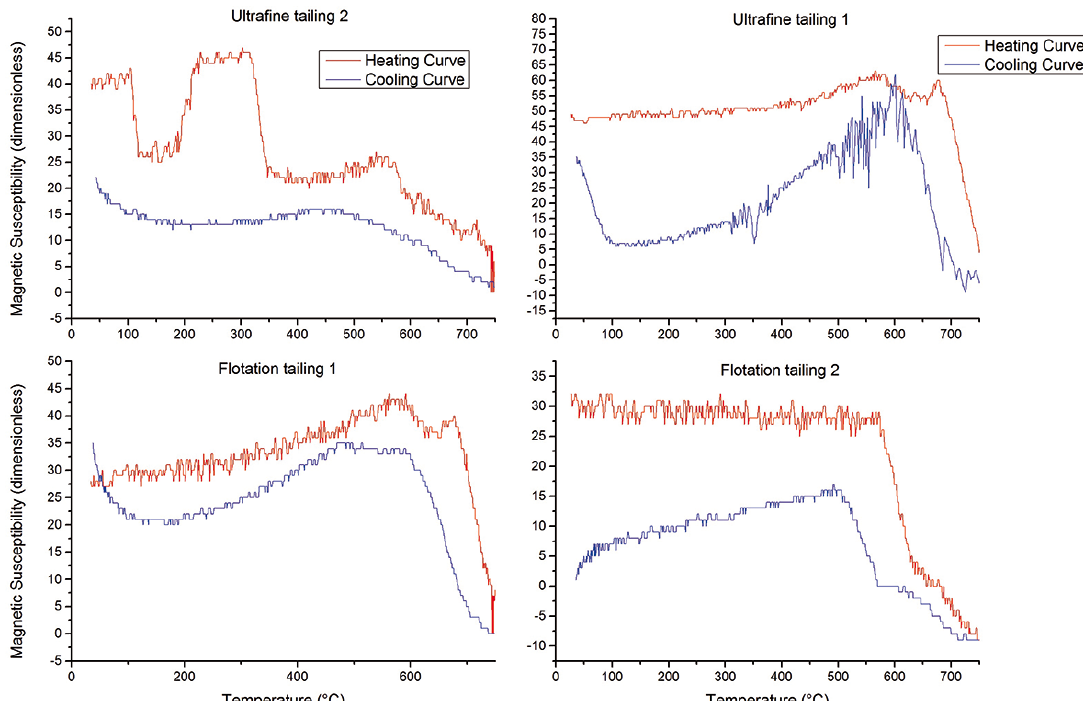
Figure 5. Thermomagnetic curves of the